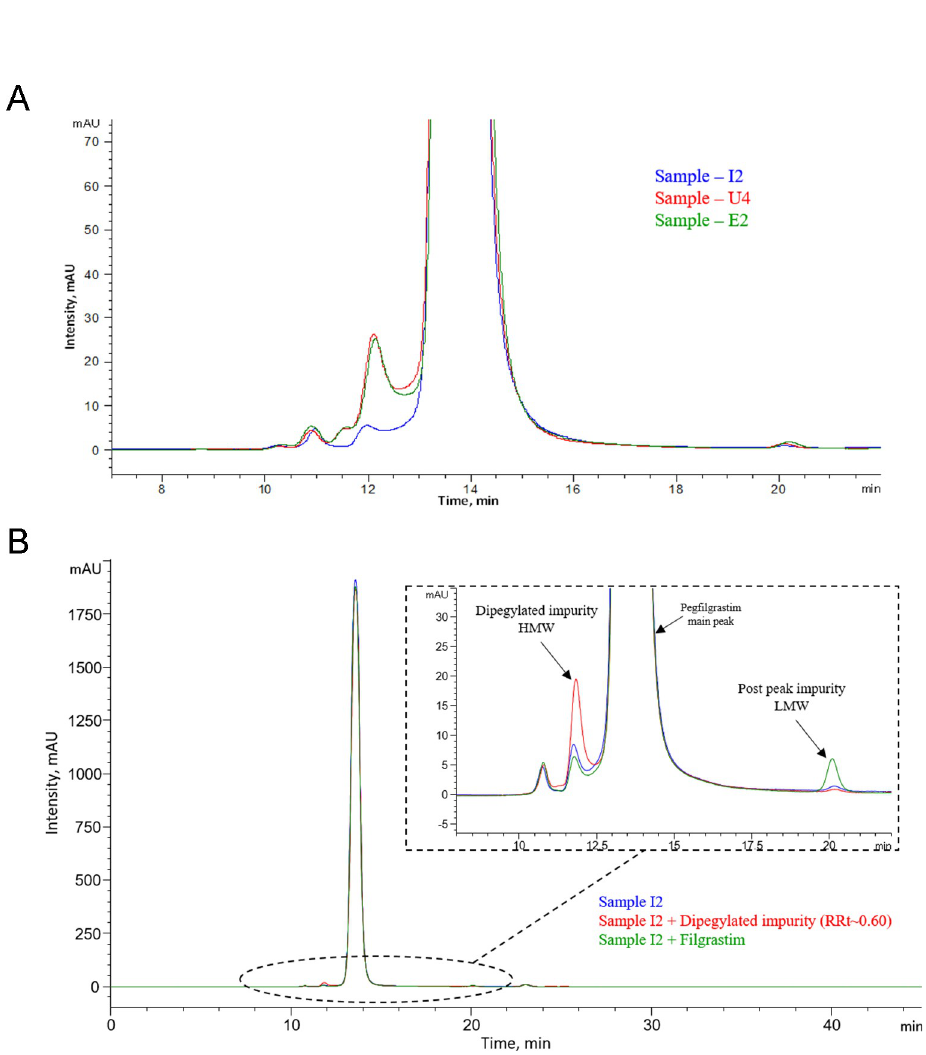
Fig 14. (A) Overlay of SEC-HPLC chromatographic profile of INTP5, US Neulasta and EU Neulasta (Sample I2, U4 and E2) (B) SEC-HPLC profile of spiking Low Molecular weight (Filgrastim, F1) (green) and High Molecular Weight (purified dipegylated filgrastim) (Red) impurities in